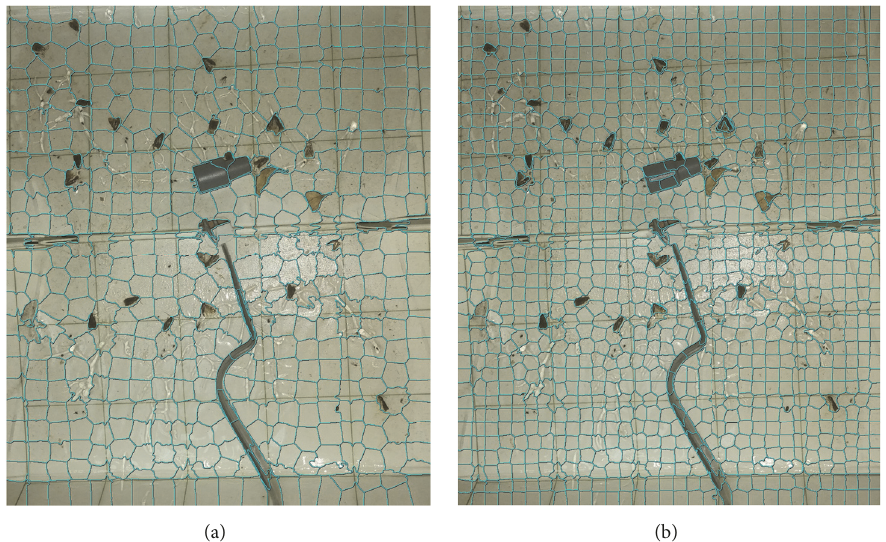
Figure 8: (a) corresponds to a segmentation considering 500 segments. (b) corresponds to segmentation considering 1000 segments.